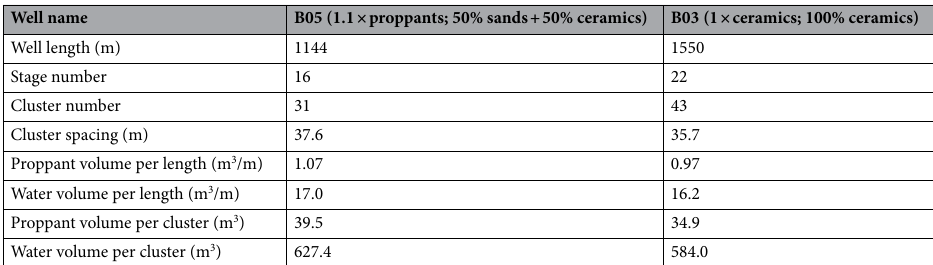
Table 2. Information of comparison wells in the Ma-18